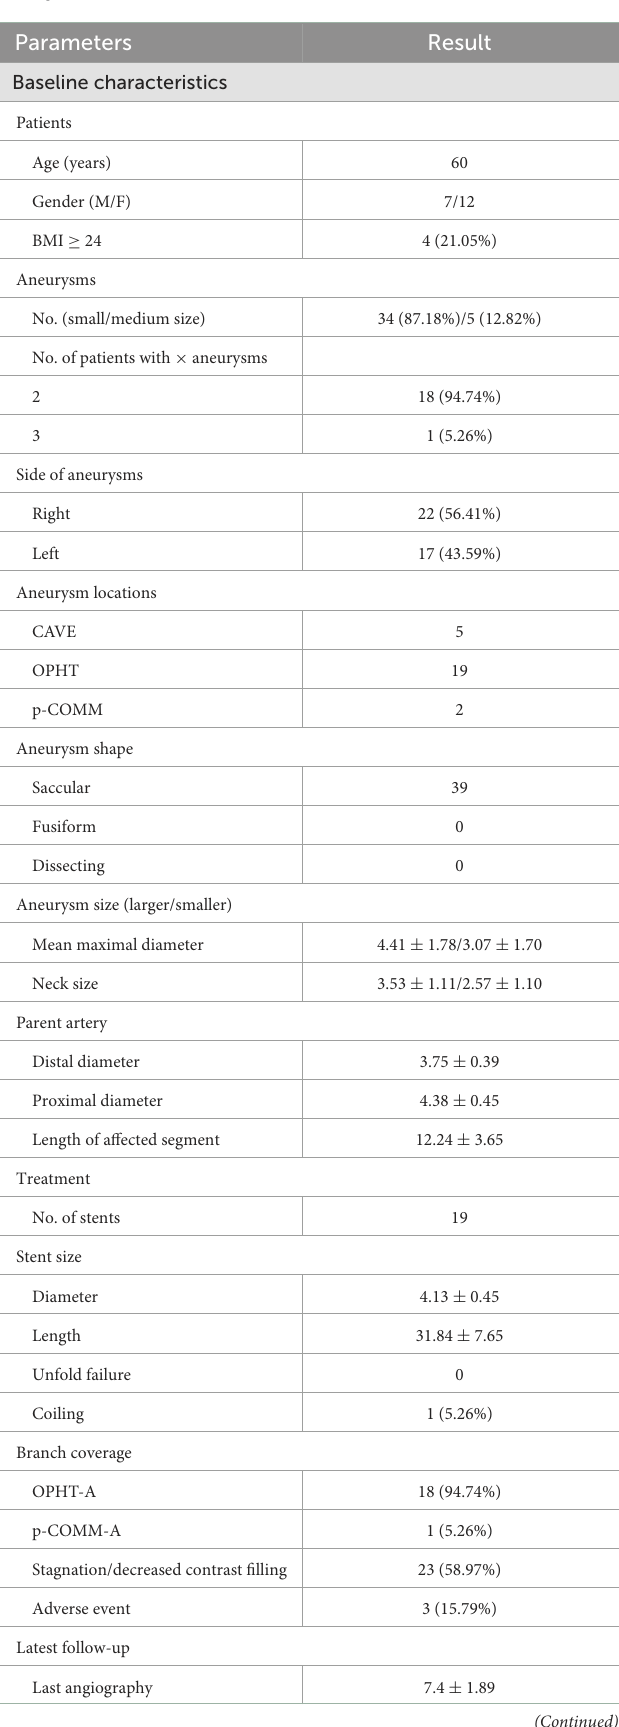
TABLE 3 Outcome measures of follow-up. TABLE 4 Baseline characteristics, treatment and follow-up of tandem